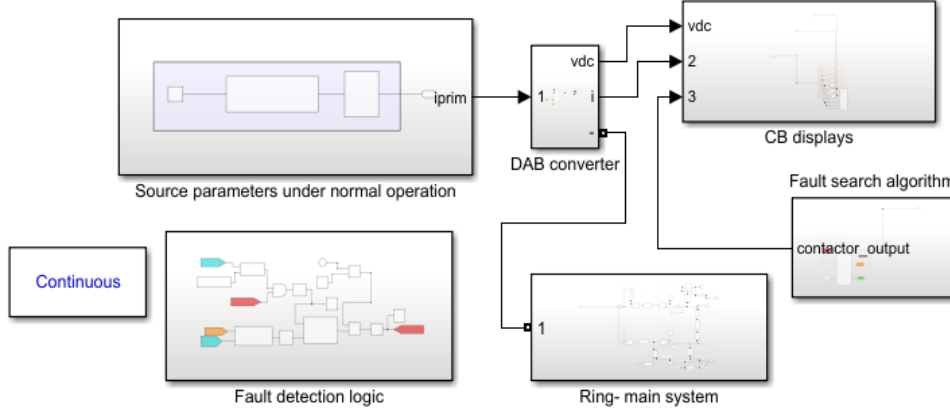
Figure 7. Simulink model with PI controller for fault detection logic and renewable energy source parameters normal operation controller.